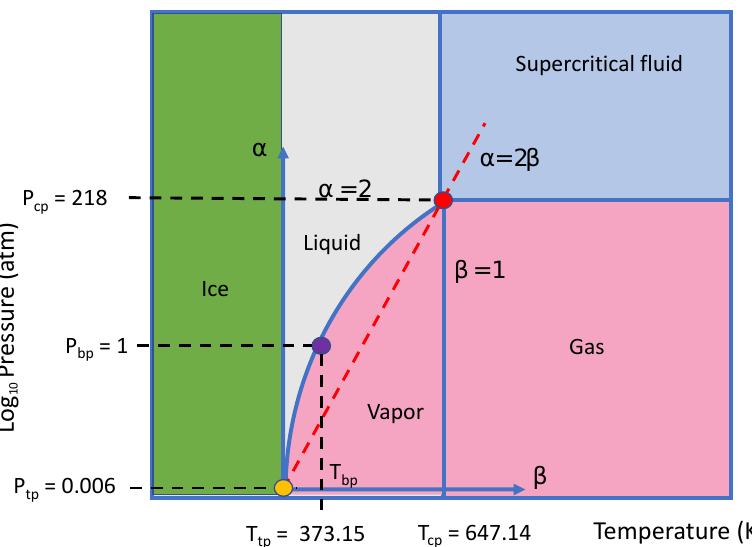
Figure 6. Composite pressure–temperature { P , T } phase diagram of water with an overlap of the fractional anomalous diffusion { β , α } phase diagram. The critical point of water is taken to be equivalent with the Gaussian case of normal diffusion using the normalization for (cid:2) (cid:0) (cid:1) (cid:0) (cid:1)(cid:3) (cid:2)(cid:0) (cid:1) (cid:0) (cid:1)(cid:3) P / P tp P cp / P tp T − T tp T cp − T tp α = 2 log / log and β = / . In this example, the triple 10 10 point of water appears at the origin of the anomalous diffusion diagram, while the boiling point is at the location { β = 0.27, α = 0.97 } (Figure is from Ref. [17]) with